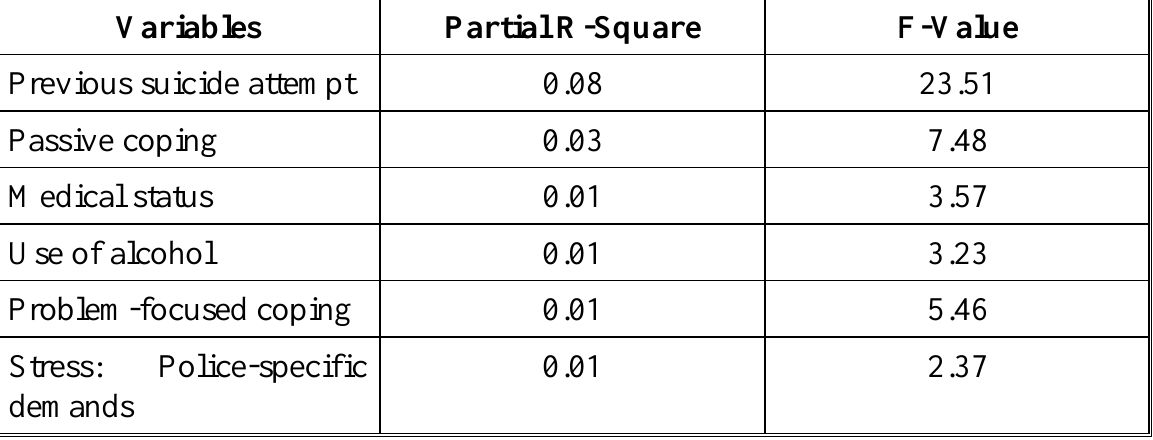
Variables that predict suicide ideation in police